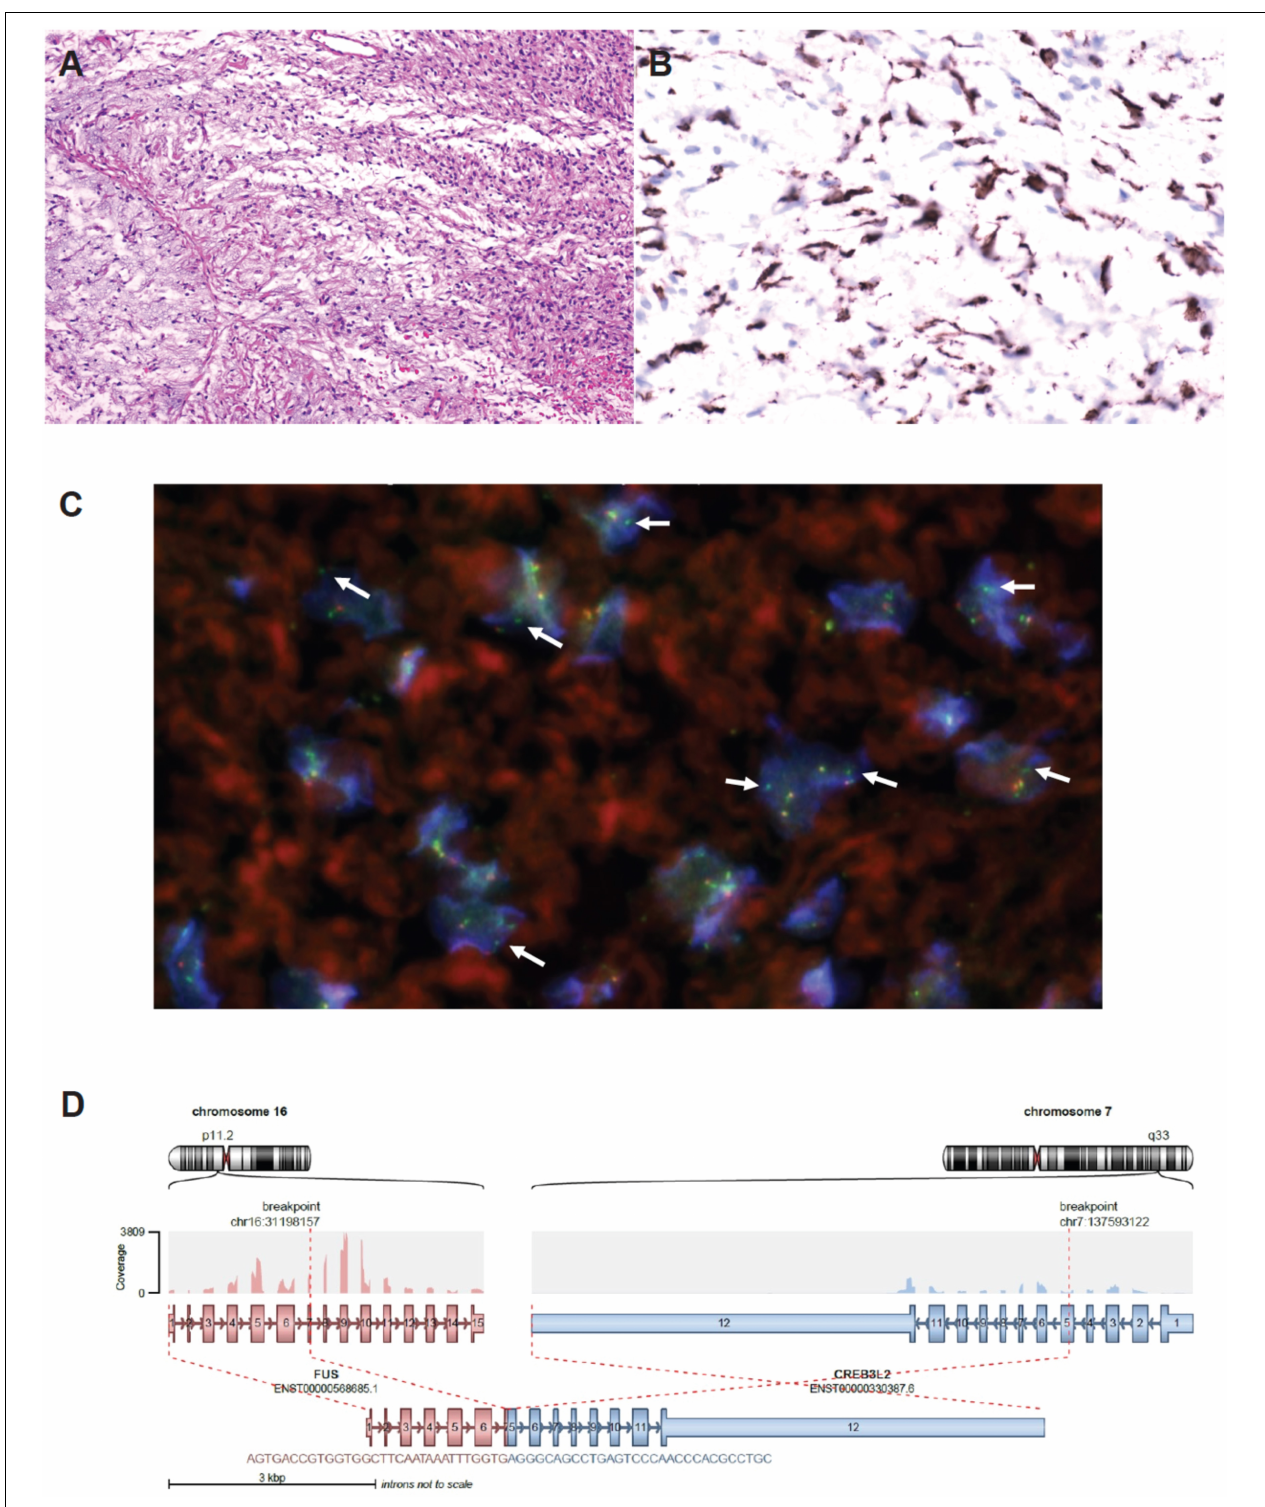
FIGURE 2 | (A) H&E staining on the tumor biopsy specimen – abnormal spindle cells with scattered small-sized blood vessels; focal myxoid area was noted without mitosis, necrosis or rosette formation. (B) Diffuse and strong MUC4 positive shown in the spindle cells. (C) FISH study with nuclei showing isolated green FISH signal (5 (cid:48) end of FUS gene) compatible with presence of FUS translocation (courtesy of Prof Ka-Fai To, Chinese University of Hong Kong). (D) RNA sequencing confirming FUS - CREB3L2 chimeric transcript.